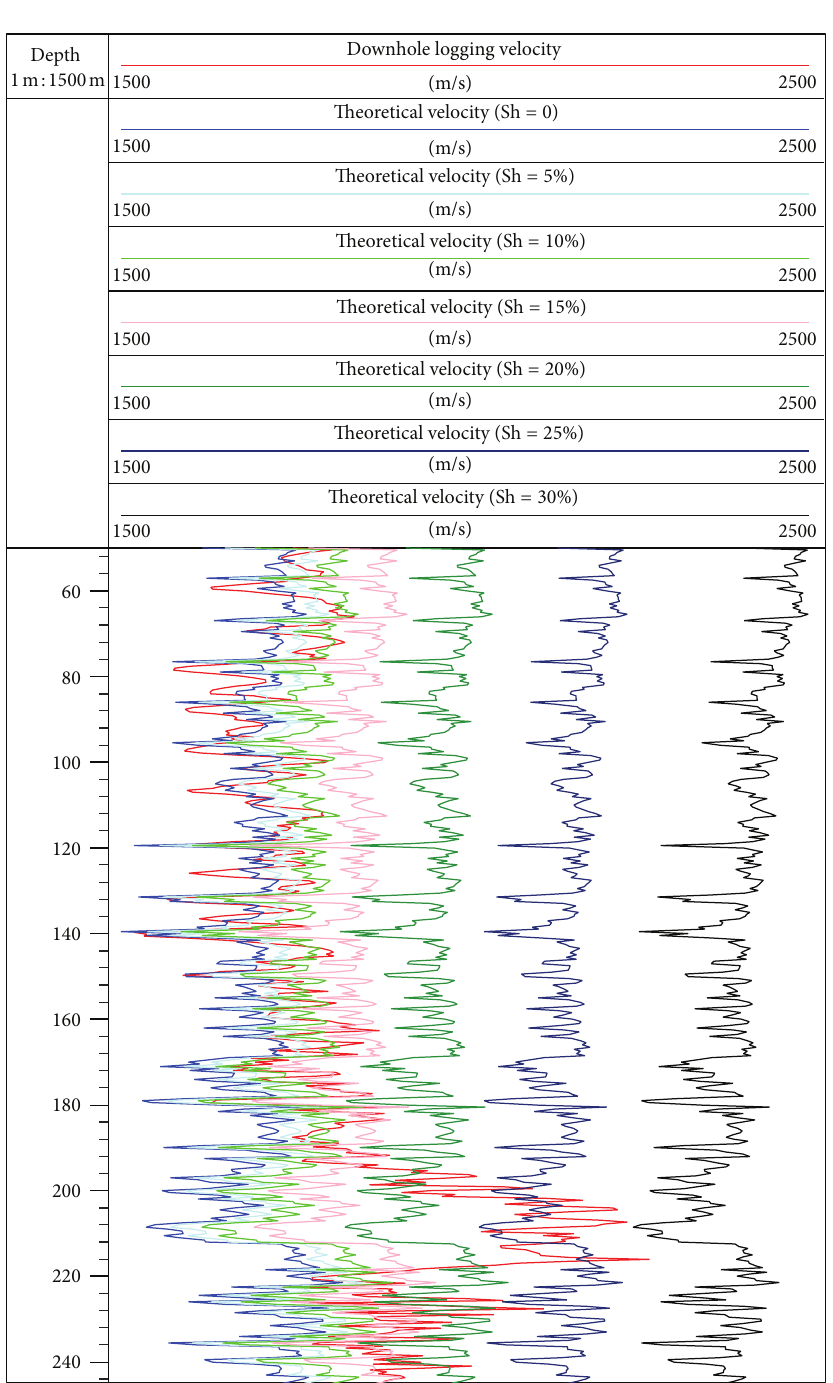
Figure 4: Forward stimulating P wave velocity of sediment formation at site SH2. (The red line is the actual log P wave velocity at site SH2; the blue line, sky blue line, bright green line, pink line, green line, dark blue line, and black line are assumed to P wave velocity made by forward modeling of the gas hydrate model when gas hydrate saturations are 0, 5%, 10%, 15%, 20%, 25%, and 30%, resp.)